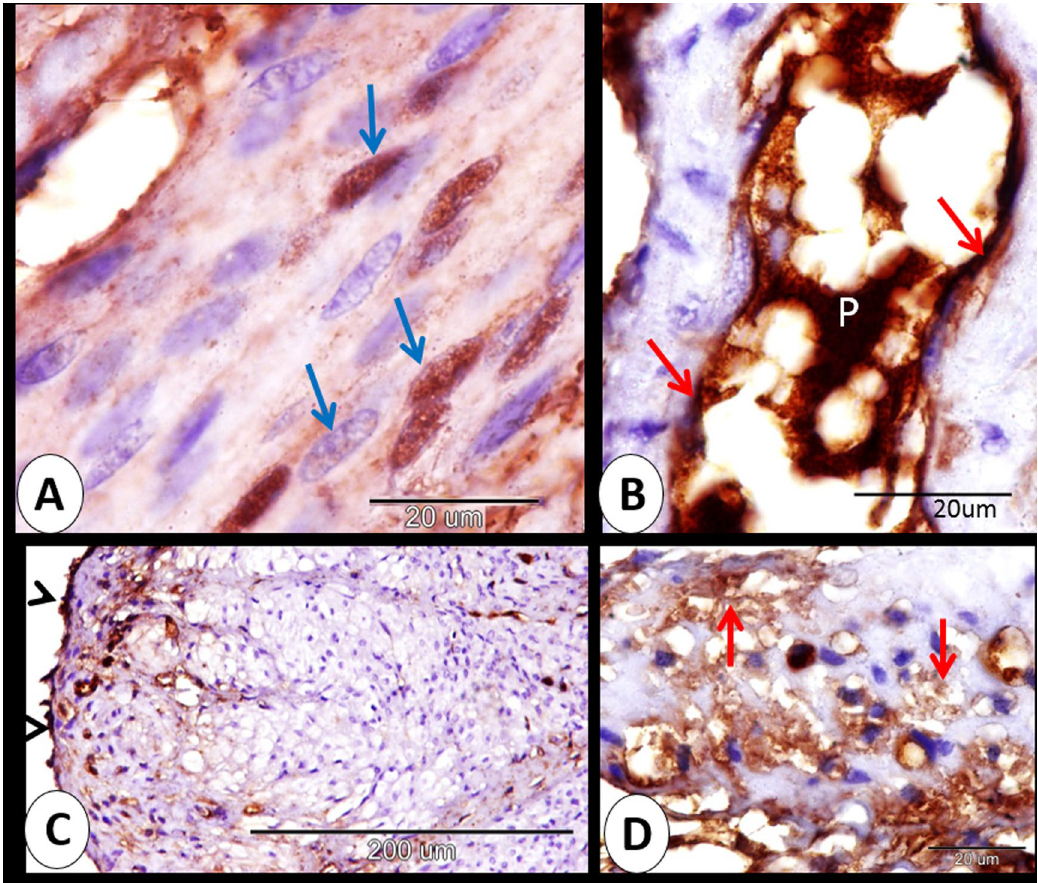
Figure 3. Immunohistochemical localization of ERA in rabbit cervix at 7 days of pregnancy. ( A ) smooth muscle fibers (blue arrows) showed mild cytoplasmic and moderate to strong nuclear immunoreactivity of ERA. ( B ) the endothelium of the blood vessels (red arrows) showed strong immunoreactivity to ERA and the blood plasma (P) demonstrated strong immunoreactivity to ERA. ( C , D ) Serosal mesothelium (black arrowheads) and serosal interstitium (red arrows) showed strong ERA